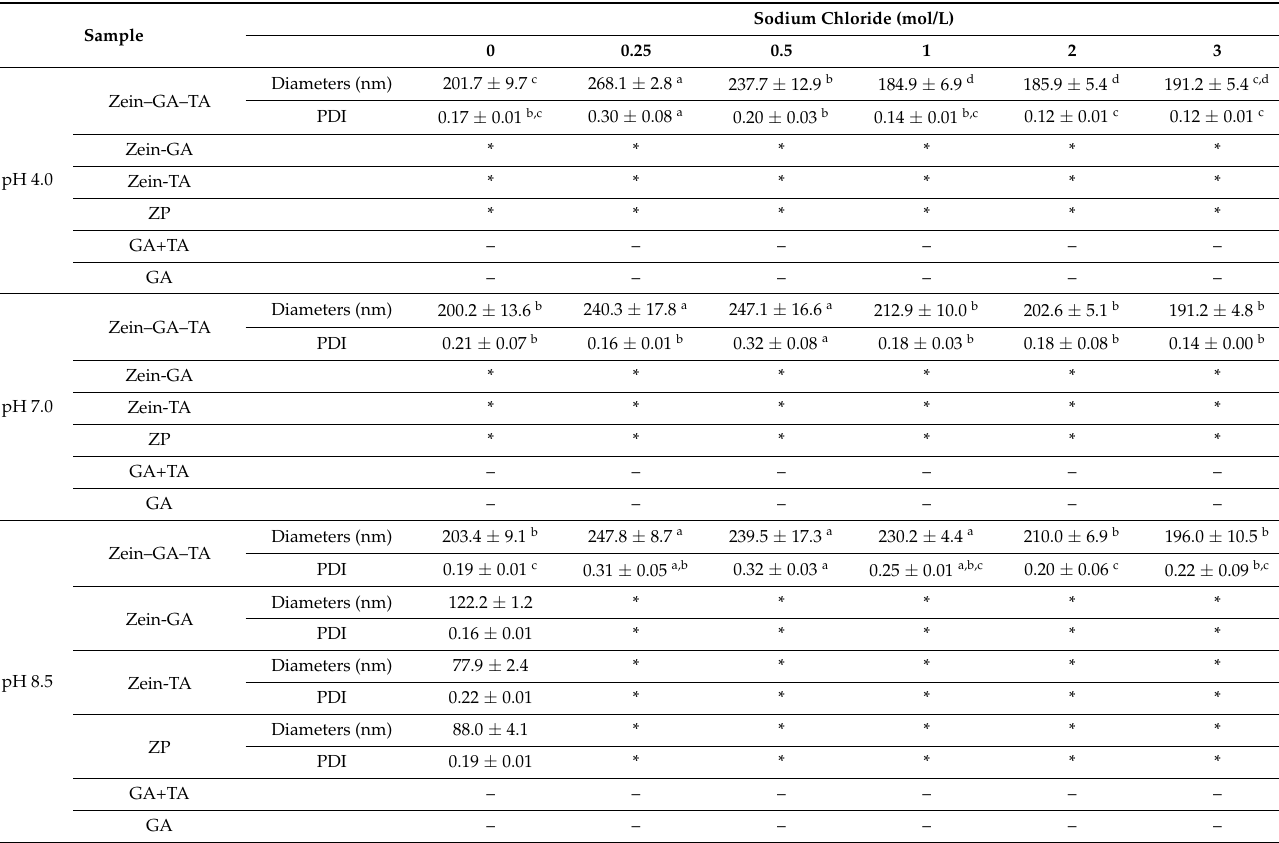
Table 1. Mean diameters and polydispersity indices of the gel particles at different pH values.